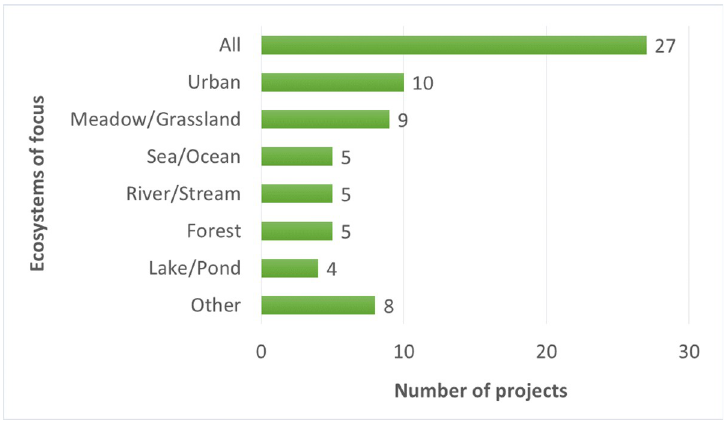
Fig 5. Ecosystems that are the focus of the participating projects (multiple answers possible).